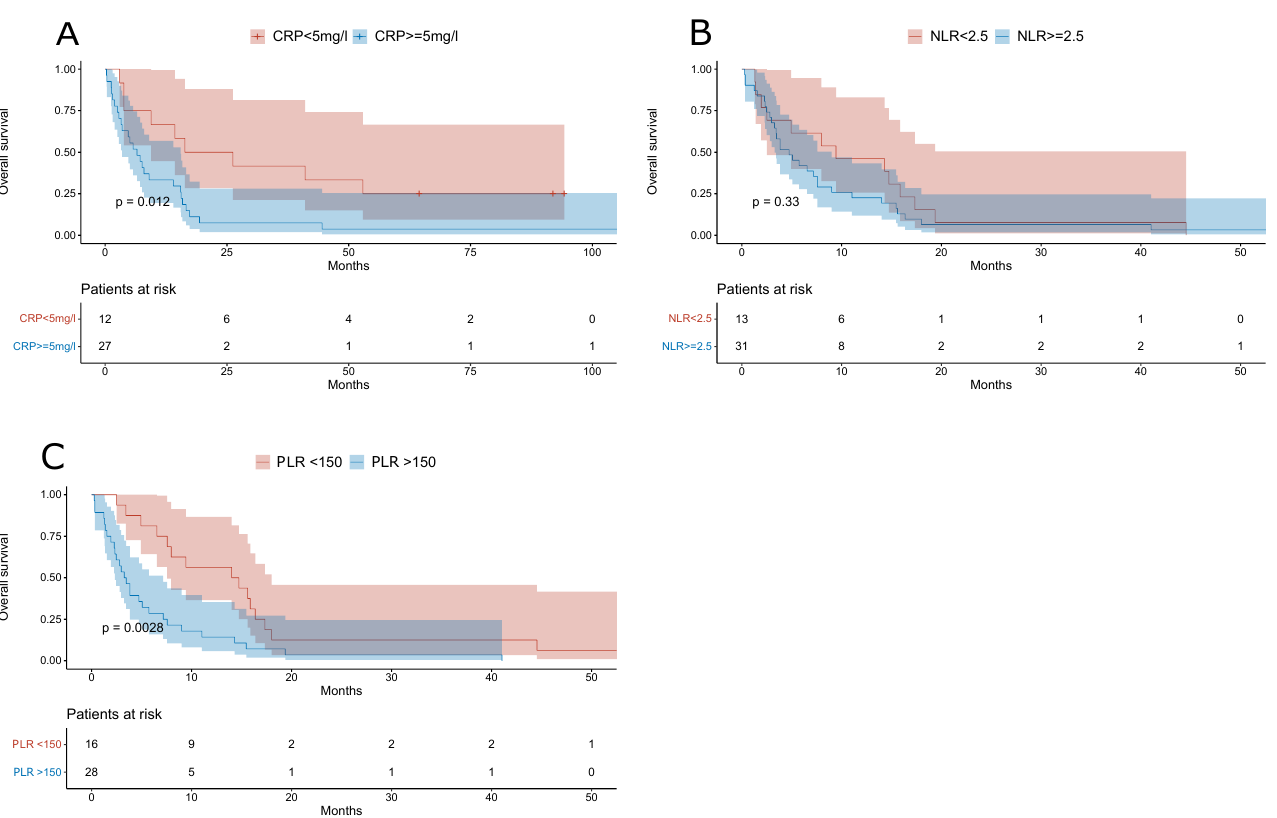
Figure 6. ( A ) Overall survival of NAFLD-related HCC patients stratified by the baseline CRP value (cut-off, 5 mg/L). ( B ) Overall survival of NAFLD-related HCC patients stratified by the baseline NLR (cut-off, 2.5). ( C ) Overall survival of NAFLD-related HCC patients stratified by the baseline PLR (cut-off, 150). NAFLD-related HCC patients with ALBI Grade 3 had worse overall survival